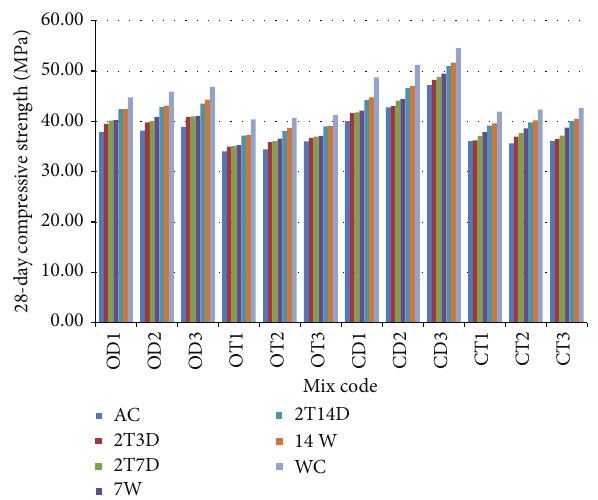
Figure 10: Relationship between early age (1-, 3-, and 7-day) and 28- day compressive strength for mixes made from different OPS species (original and crushed) and age categories.